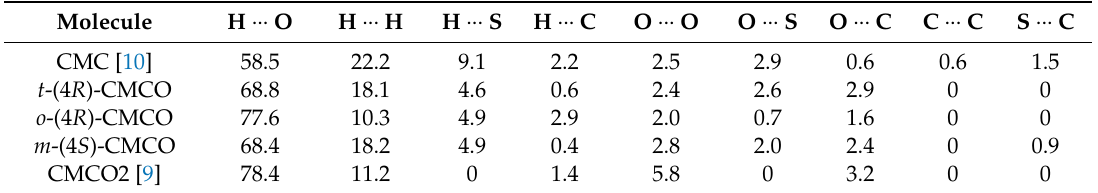
Table 2. Contributions (%) of the intermolecular contacts to the Hirshfeld surfaces [12] of S -carboxymethyl-L-cysteine and its oxidation products.